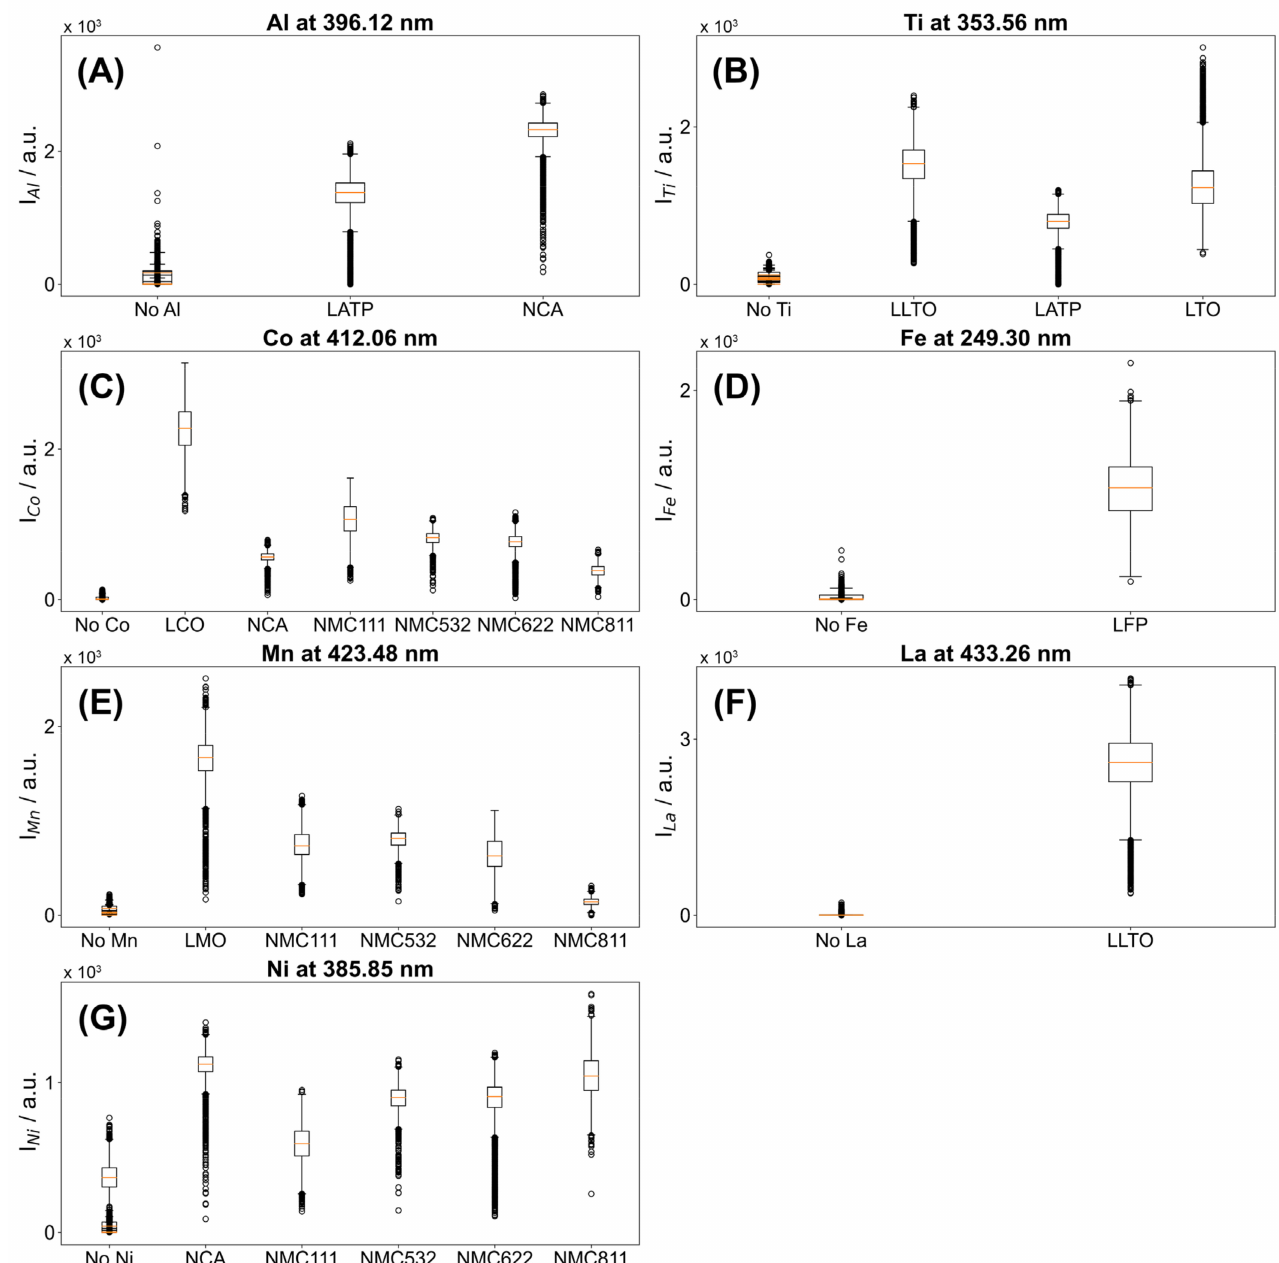
Figure 5. Boxplot of the intensities of ( A ) Al, ( B ) Ti, ( C ) Co, ( D ) Fe, ( E ) Mn, ( F ) La, and ( G ) Ni emission lines in different